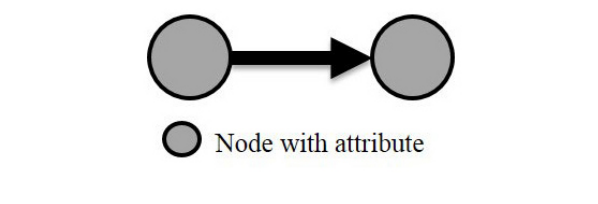
Fig. 4 . Coordination tie based on matched attribute.